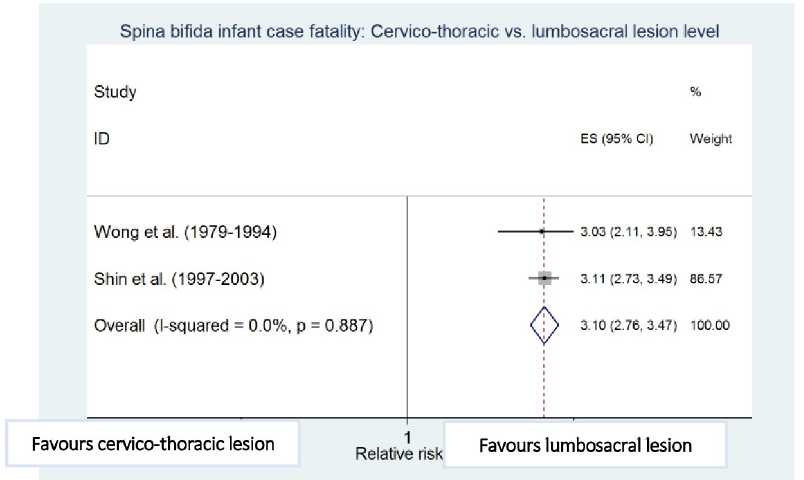
Fig 9. Lesion level. Spina bifida infant case fatality risk